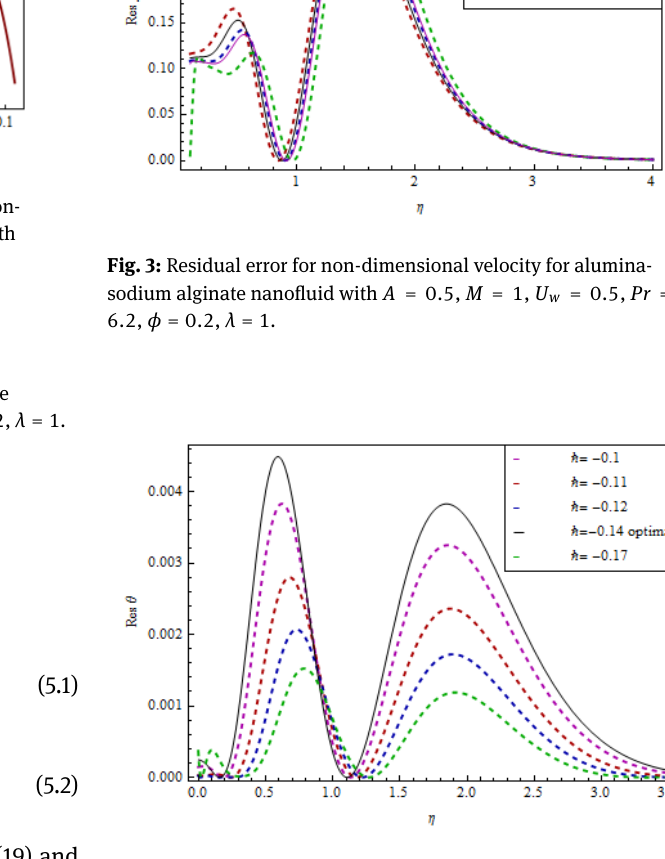
Fig. 4: Residual error for non-dimensional temperature for alumina- sodium alginate nanofluid with A = 0.5, M = 1, U 6.2, ϕ = 0.2, λ =